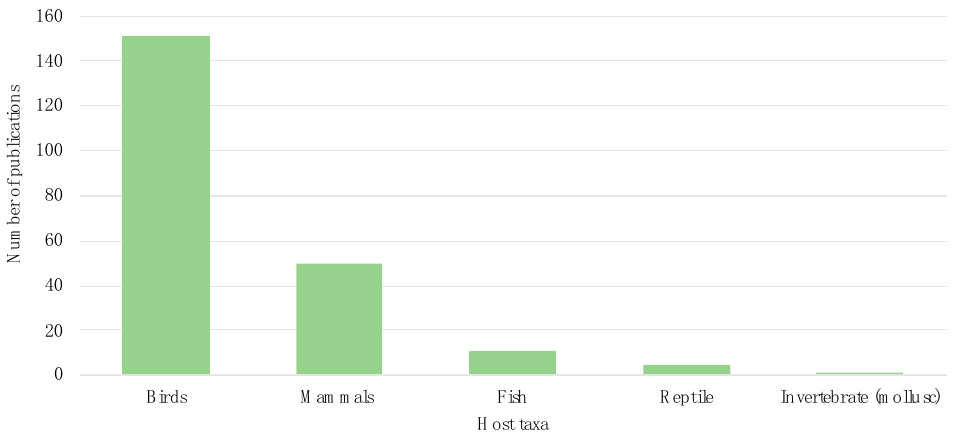
6 of 19 Figure 2. Distribution of publications among the top 10 publishing countries on cephalo- sporinases occurrence in wildlife. 3.2. Host Taxonomy